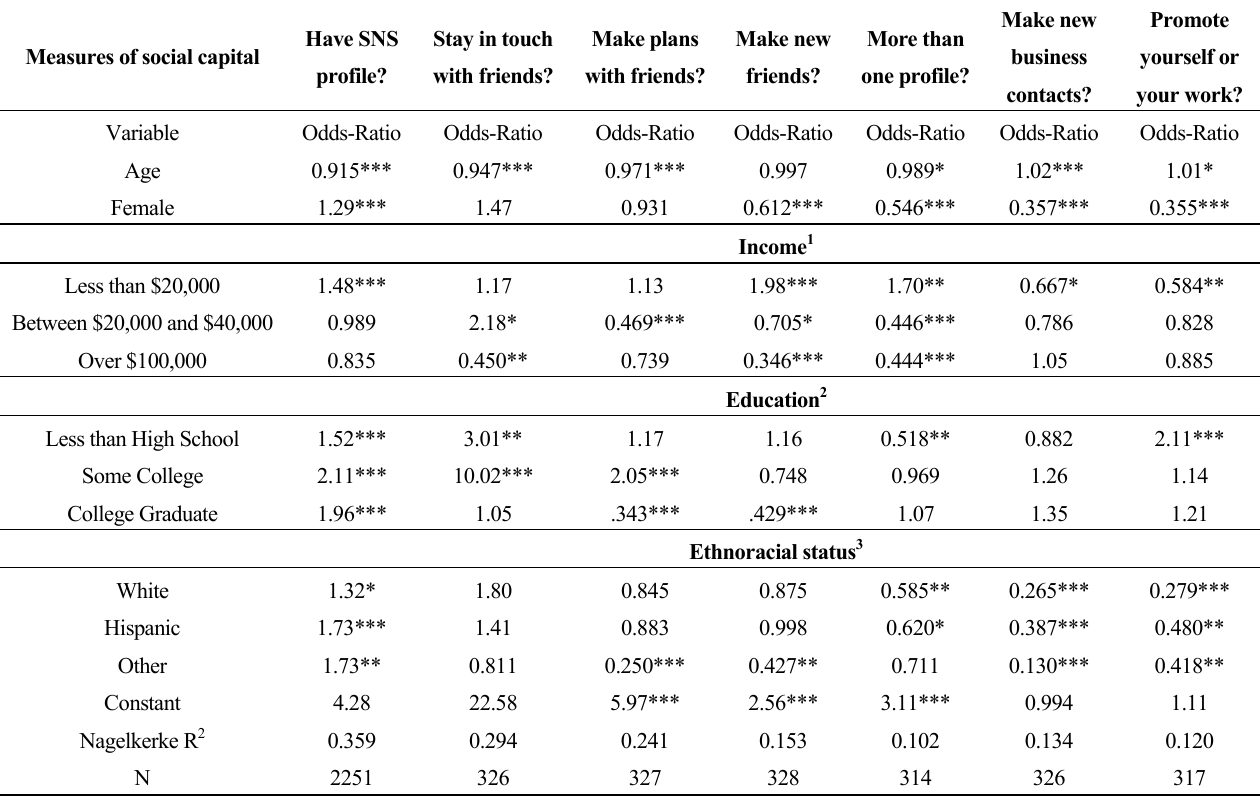
Table 3. Binary logistic regressions for social capital